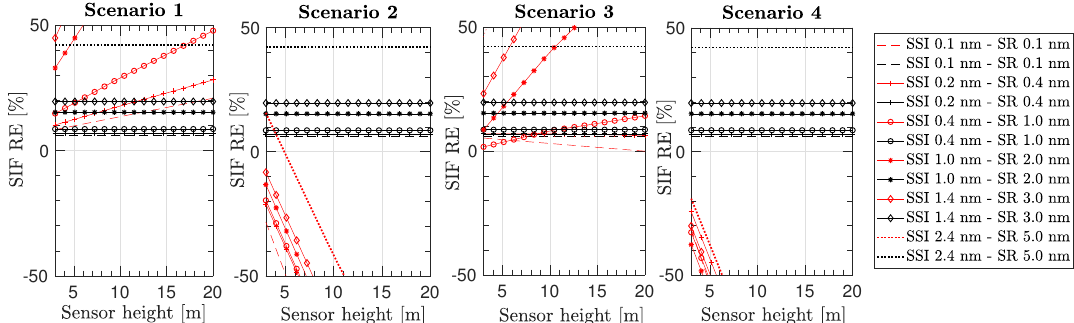
Figure 8. Relative error (%) on retrieved SIF in the O 2 –A region when applying the 3FLD method according to Equation (8) for a range of spectral resolutions, applied to set–up configurations 1–4 (red symbols and lines) from left to right panels, respectively. The SIF relative error obtained when applying the 3FLD at TOC surface level is indicated with black symbols and